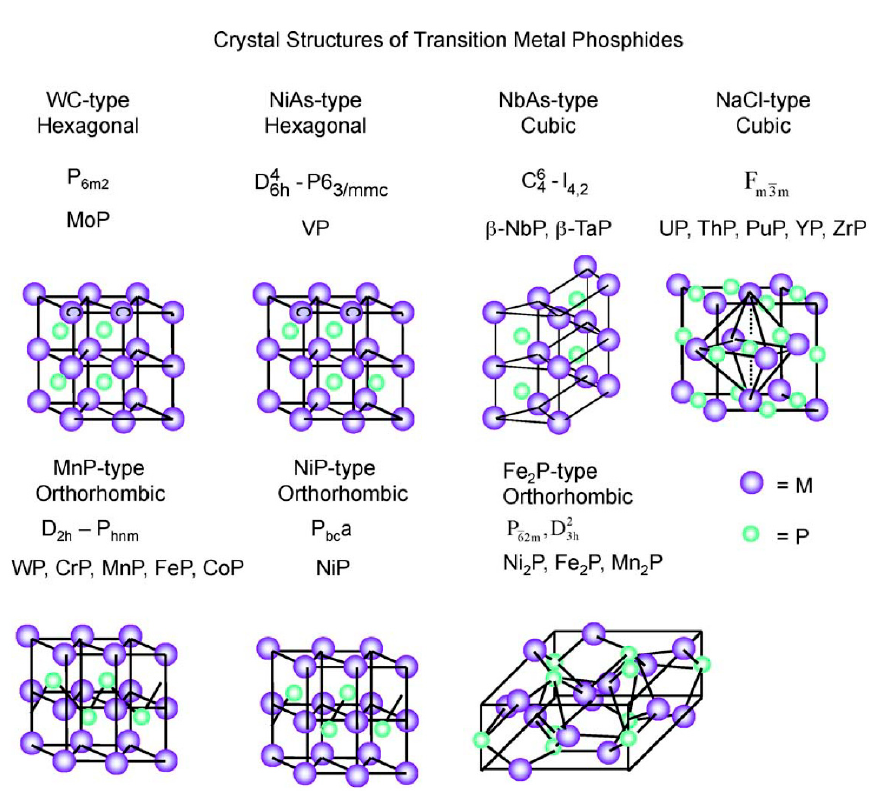
Figure 2. Crystal structures of metal-rich phosphides (Reproduced from the work of [21] with permission).